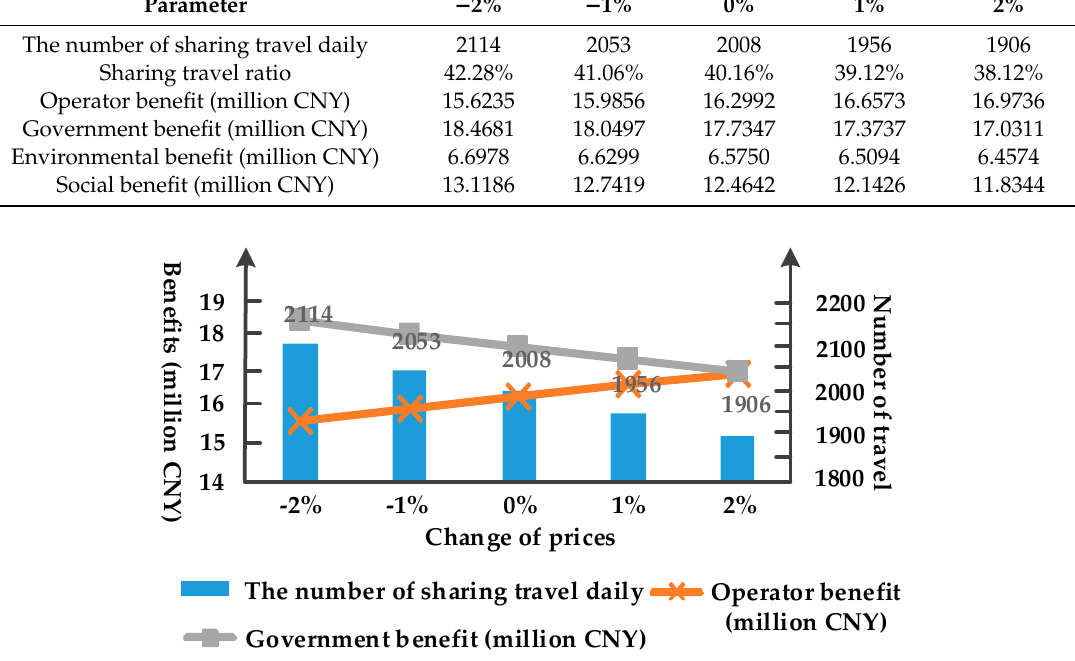
Table 4. Interests of all participants after adjustment of subsidy rates.